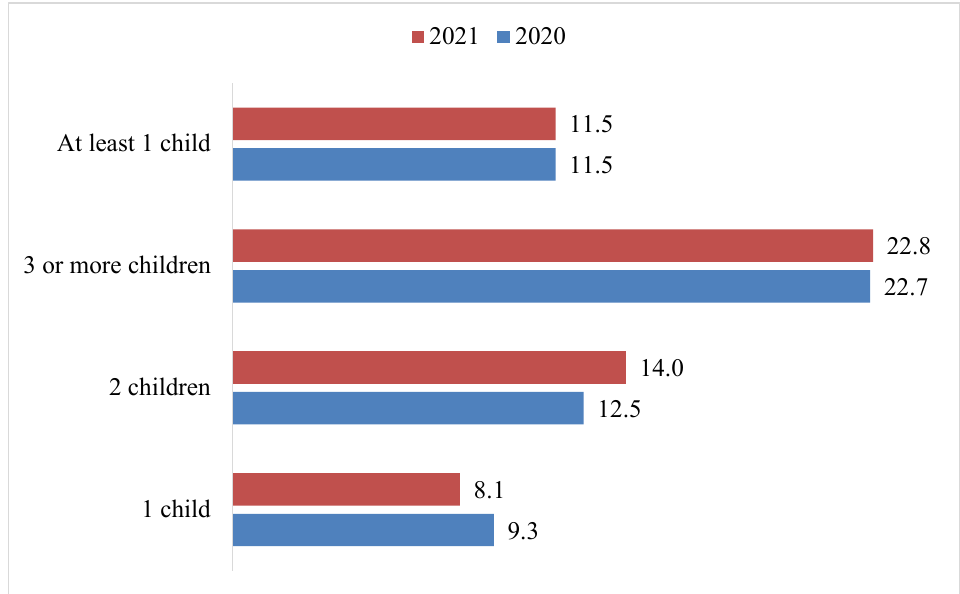
Figure 5. Poverty rate trends in households, by number of children, 2020–2021. Source: own elaboration on the Istat database.